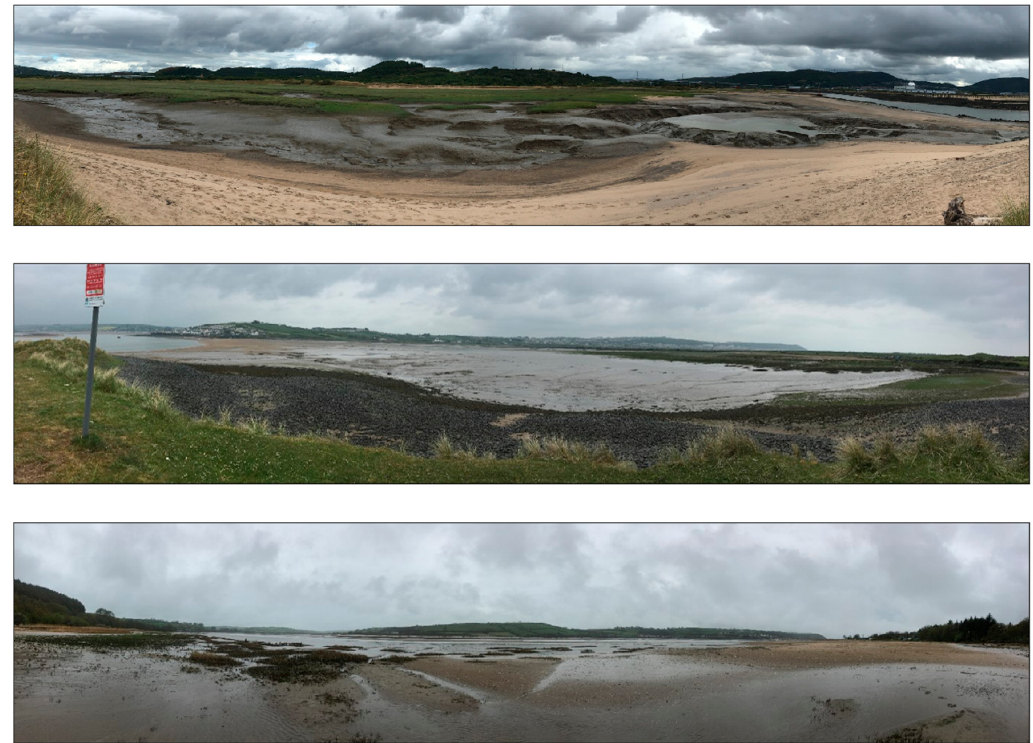
Figure 3. Panoramic photographs of the Neath Estuary site ( top ); Appledore site ( middle ) and Llansteffan site ( bottom ).